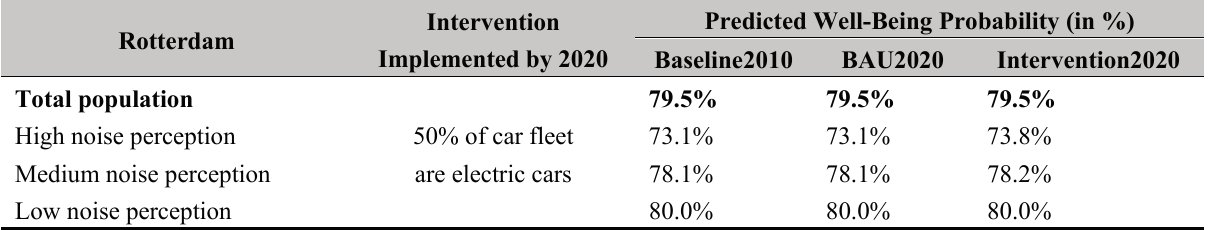
Table 8. Well-being probability in Rotterdam by noise